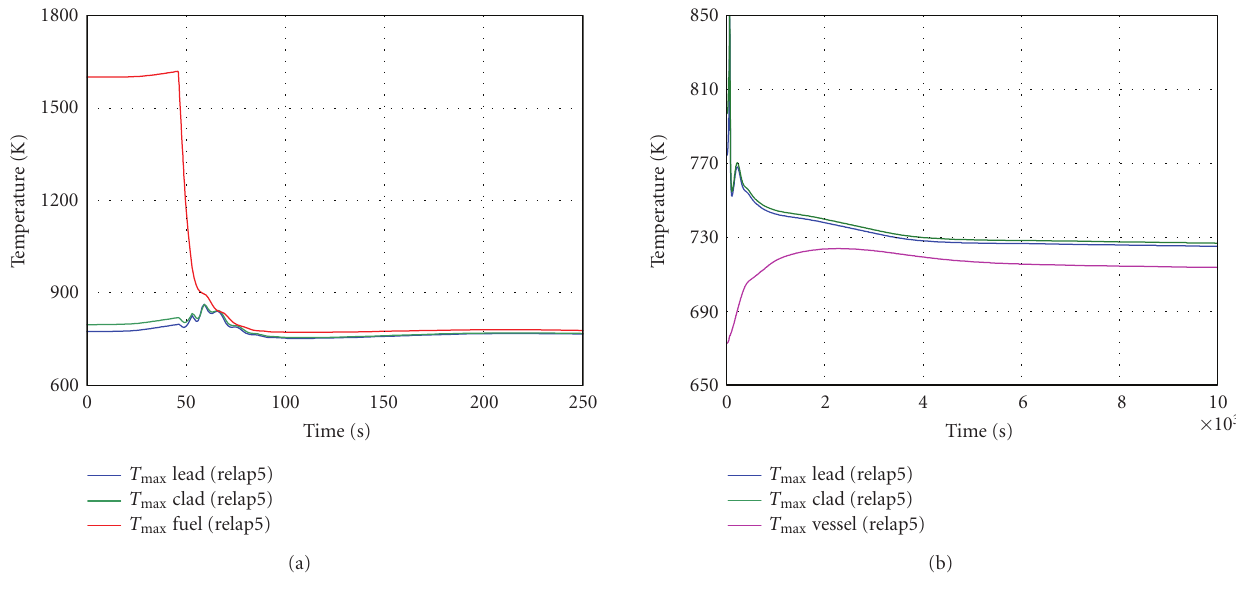
Figure 8: Maximum core (lead, clad, and fuel) and vessel wall